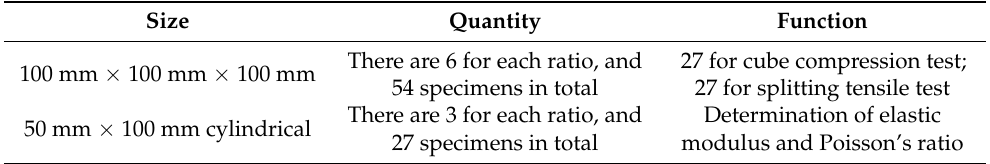
Figure 3. The prepared samples. Table 6. Parameters and application of test piece. Table 6. Parameters and application of test